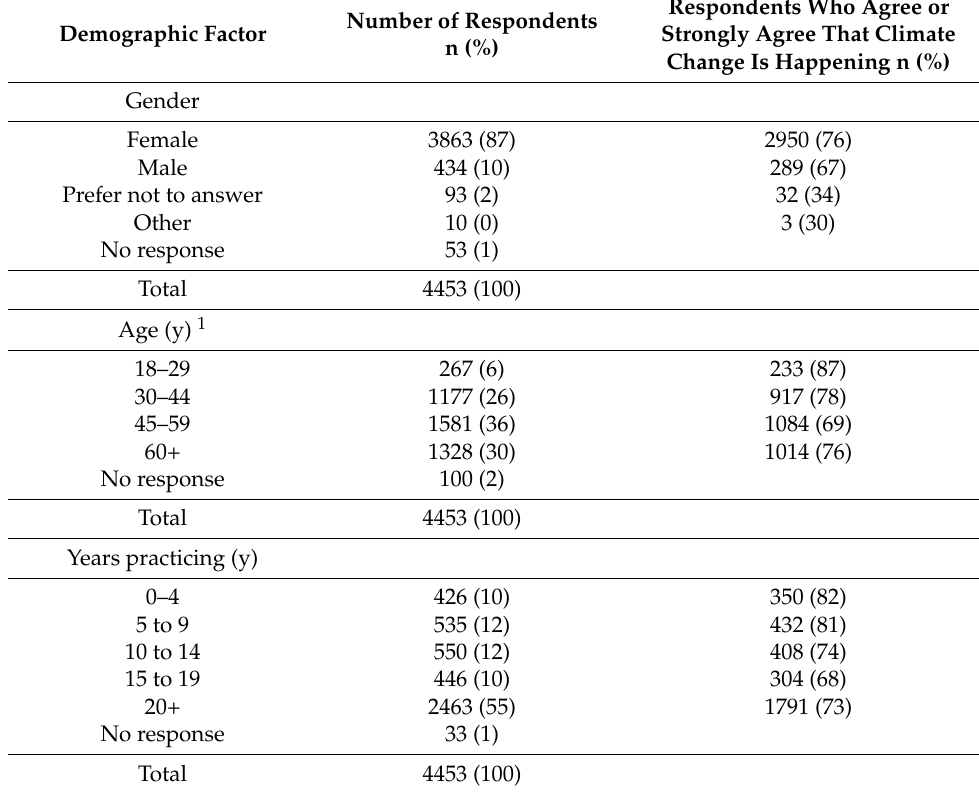
Table 1. Respondent demographics and relation to belief in climate